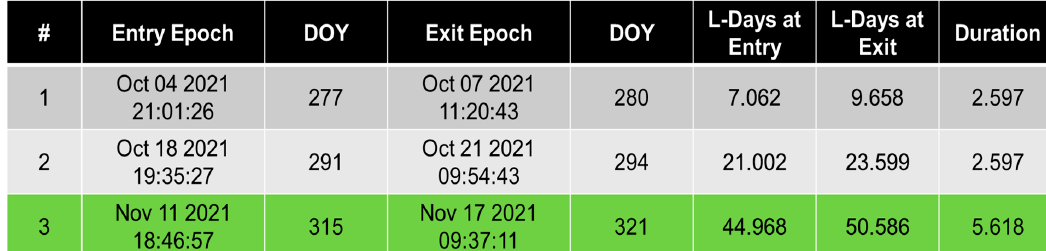
Figure 4. Landsat 9 offset from Landsat 8 in WRS-2 path difference.